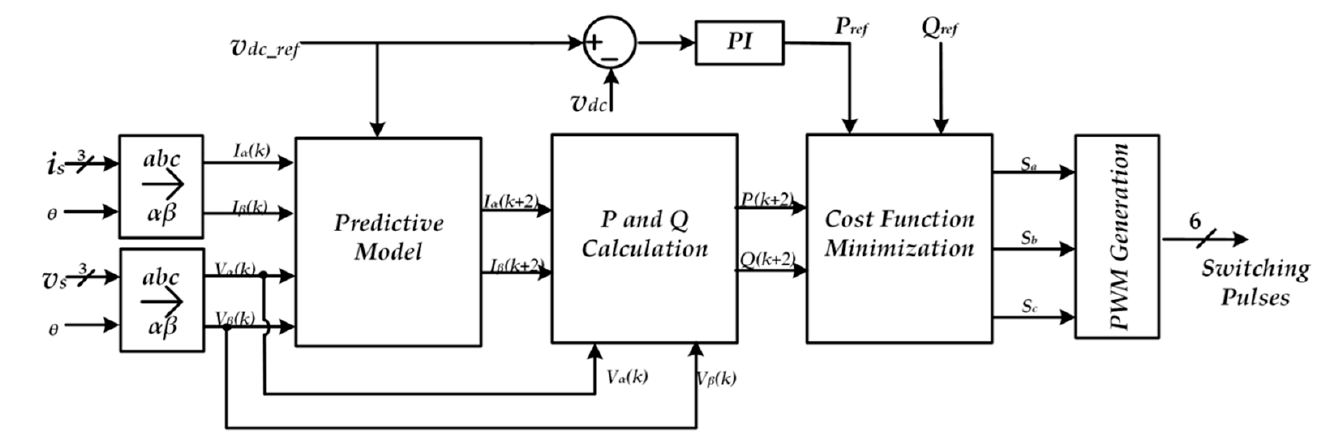
Figure 26. Model Predictive Control (MPC) Strategy for EV battery charging.